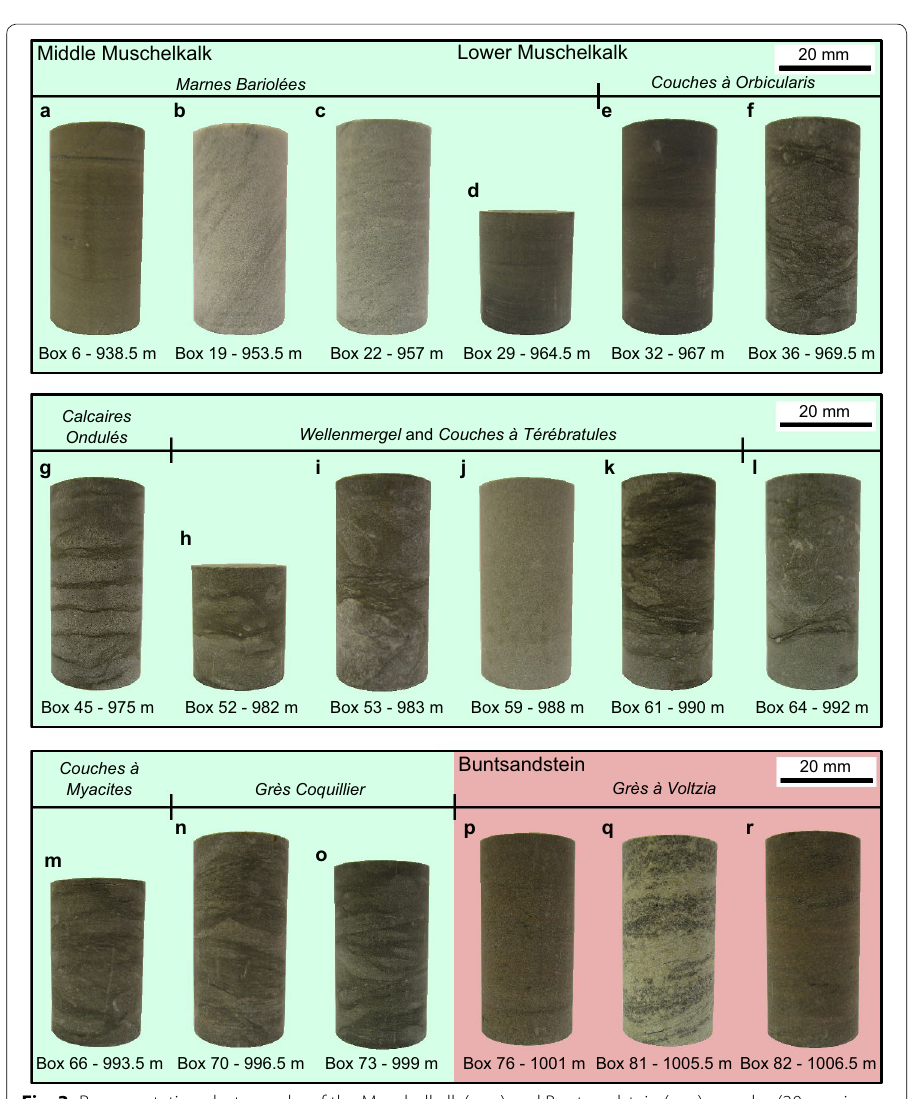
Fig. 3 Representative photographs of the Muschelkalk ( a – o ) and Buntsandstein ( p – r ) samples (20 mm in diameter) from exploration well EPS-1 (Soultz-sous-Forêts) used for this study. The box number and measured depth are given next to each